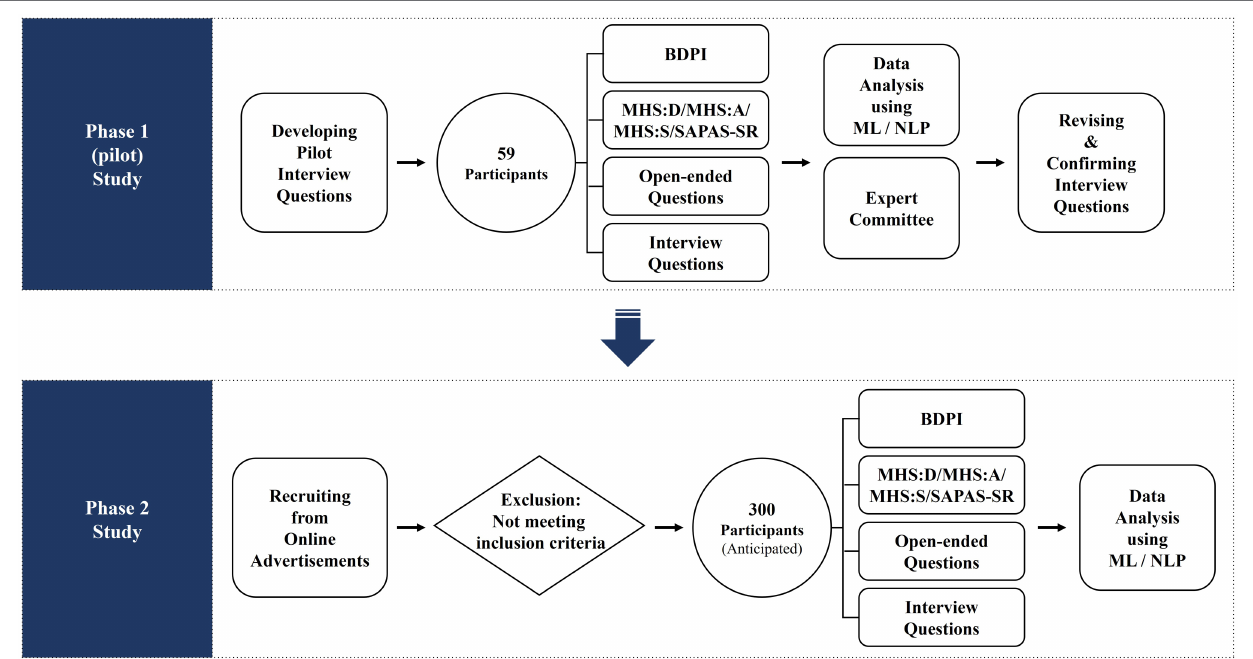
FIGURE 1 | Study design